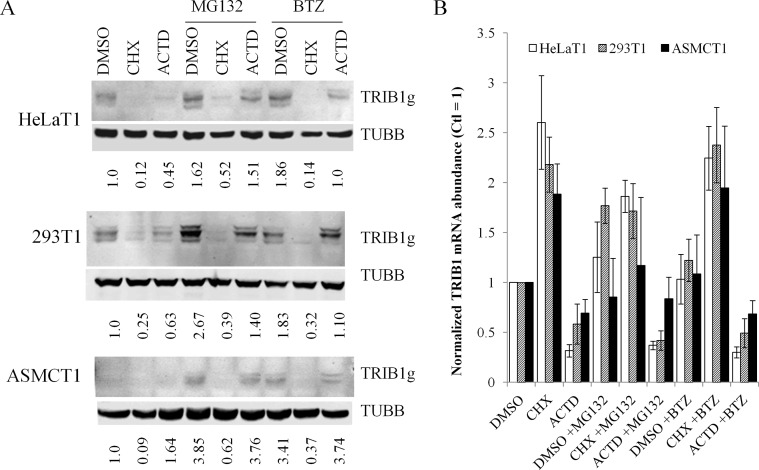
Proteasome inhibitors increase TRIB1 but do not prevent TRIB1 destabilization in stably transduced cells.Cells were treated for 5 h with vehicle, CHX or ACTD, in combination with MG132 (20 μM) or Bortezomib (BTZ, 10 μM), as indicated. A, Lysates were subjected to western blot using the indicated antibodies. B, mRNA was isolated and quantified by qRT-PCR for TRIB1. Values are normalized to vehicle alone (DMSO) and represent the mean of biological triplicates ± S.D.